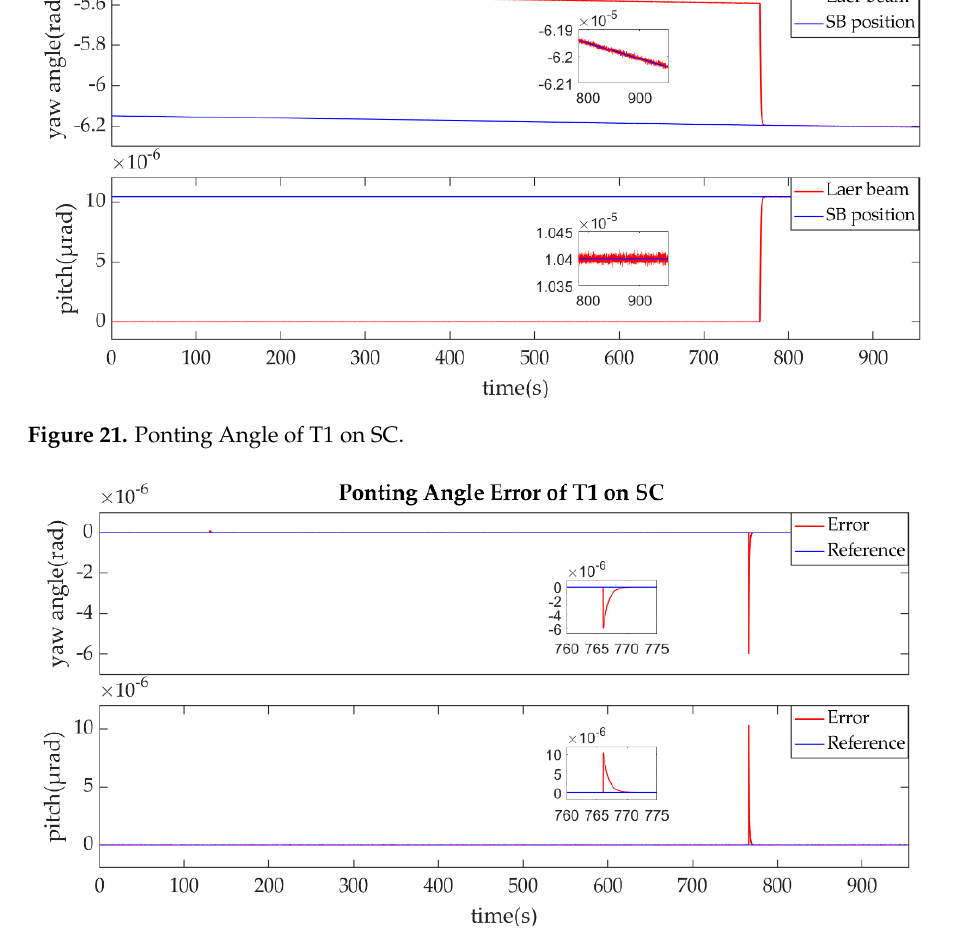
Figure 22. Ponting Angle Error of T1 on SC.